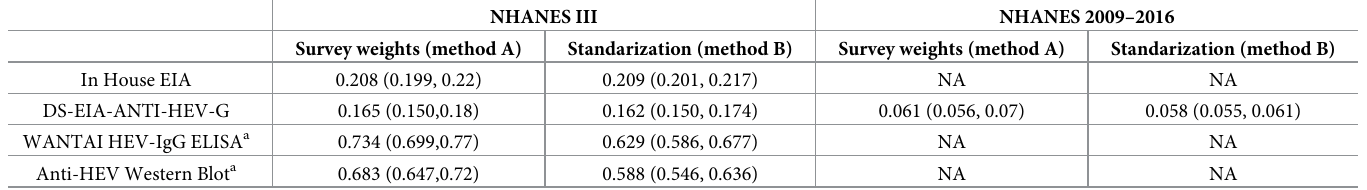
Table 1. HEV seroprevalence using survey weights (method A) and standardization (method